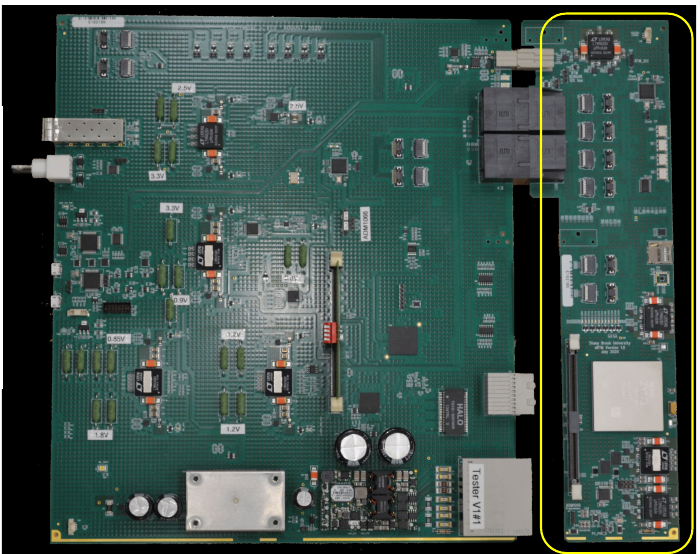
Figure 8. Image of the LASP Main Blade and the STRM, with the SRTM outlined in